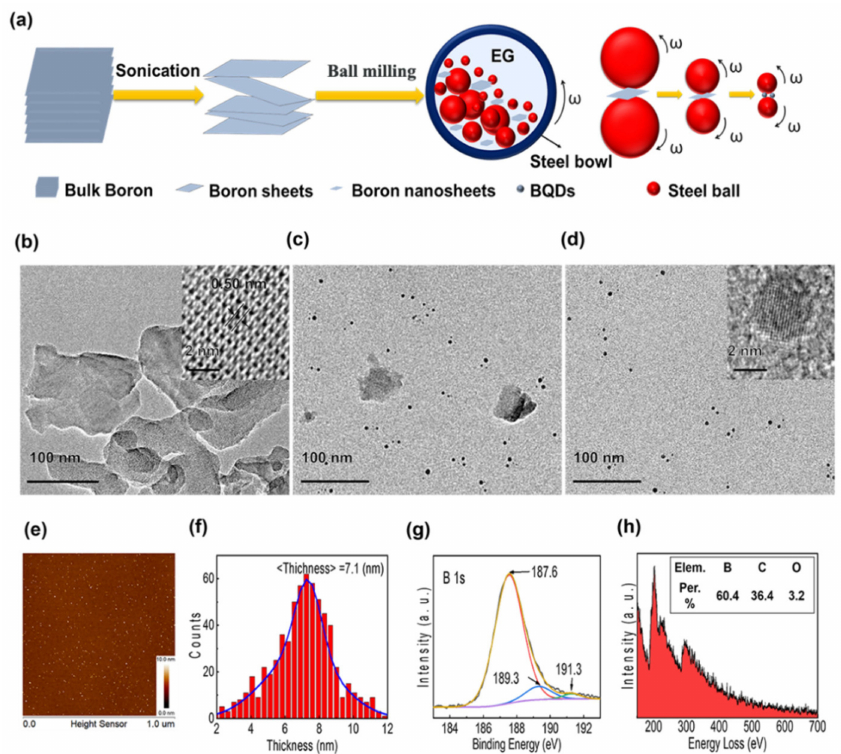
Figure 1. ( a ) schematic diagram of sonochemical and ball milling synthesis of boron quantum dots (BQDs). ( b ) TEM images of boron sheets obtained by sonochemical exfoliation in ethylene glycol (EG), the insets of (b) show the high resolution transmission electron microscope (HRTEM) of boron sheets. ( c ) TEM image of boron nanosheets (BNSs) and BQDs compound. ( d ) TEM images of BQDs, the inset of (d) shows the HRTEM of BQDs. ( e ) Atomic Force Microscope (AFM) characterization of the BQDs. ( f ) statistical data for BQDs showing the average thickness. ( g ) XPS spectrum (survey) for BQDs. ( h ) electron energy loss spectroscopy (EELS) studies of BQDs, the inset of ( h ) shows the corresponding atomic ratios of